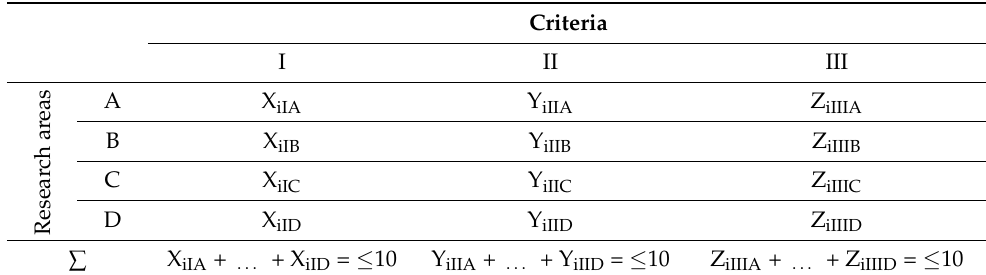
Table 4. Expert research areas’ valuation table according to given criteria with a 10-point scale. Source: Own